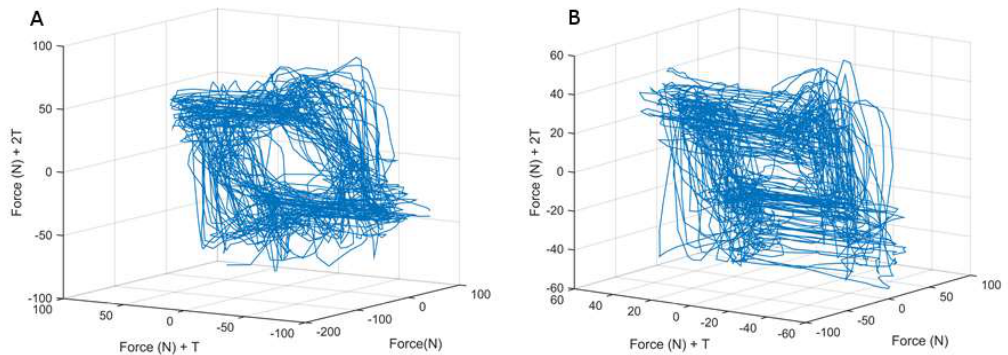
Figure 2. Depiction of trajectories of continuous movement cycles of larger and smaller Lyapunov Exponents. ( a ) Movement trajectories with a smaller Lyapunov Exponent; ( b ) Movement trajectories with a larger Lyapunov Exponent.